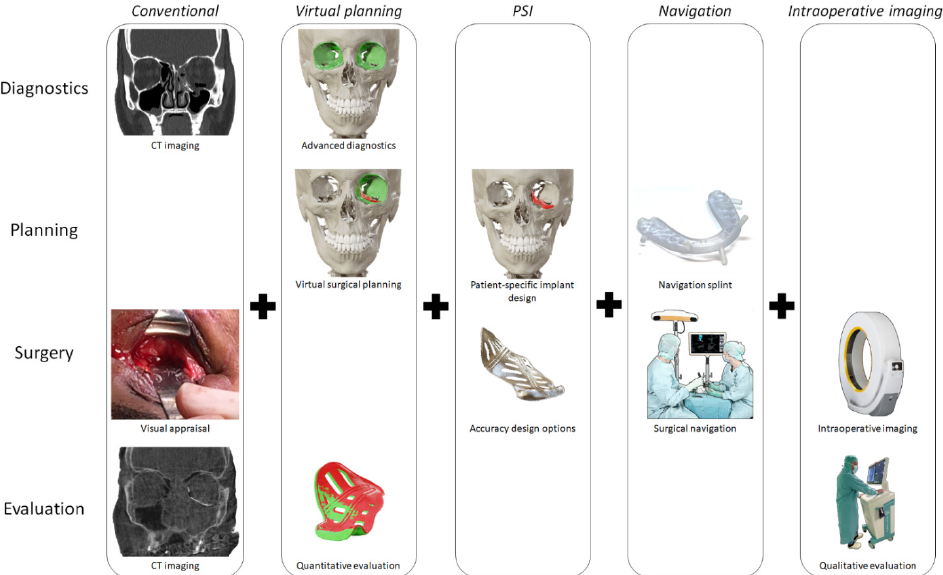
Figure 1. Schematic overview of the technological possibilities within the orbital reconstruction workflow. Chronologically, a clinical workflow consists of diagnostics, planning, surgery, and evaluation. In the conventional workflow, the surgeon is dependent on clinical assessment and preoperative imaging, visual appraisal during surgery and postoperative imaging for evaluation. CAS consists of several techniques that may be combined and affect one or multiple workflow stages. Several CAS technologies may be combined.